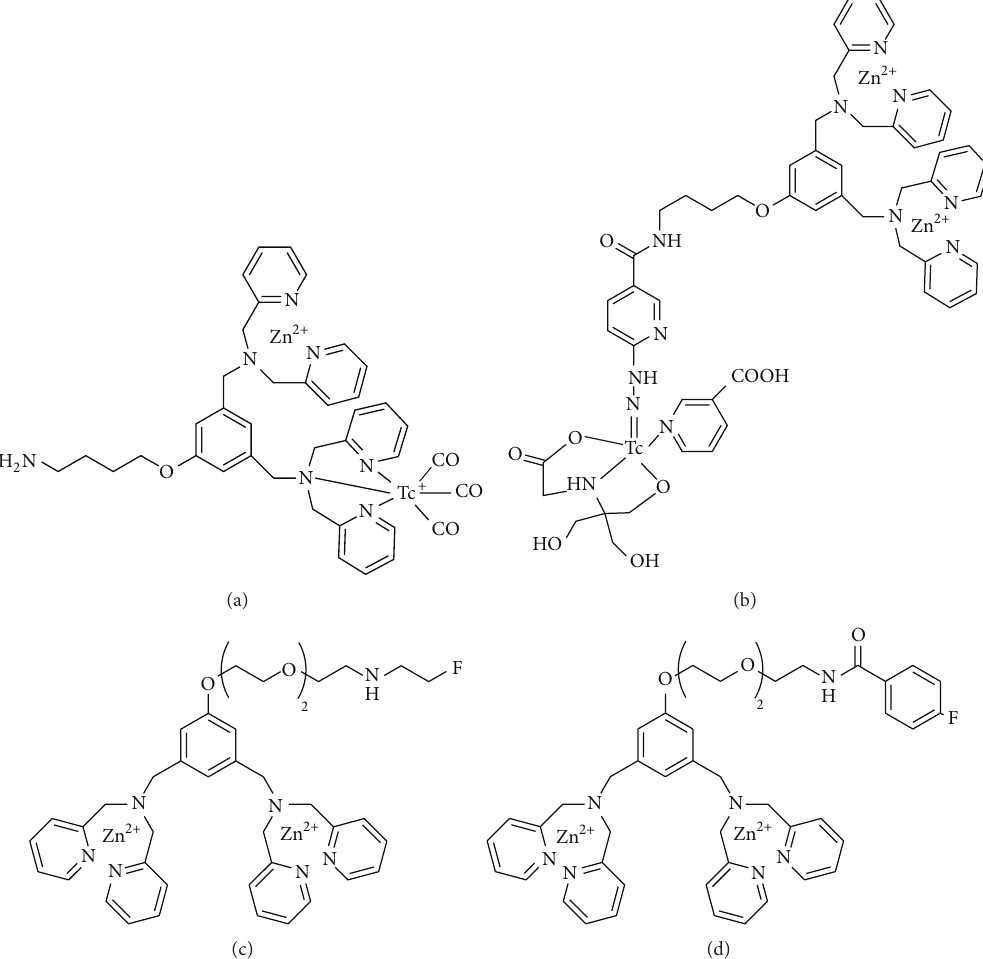
Figure 3: Structures of (a) 99 m Tc-labeled Zn 2+ -DPA with 99 m Tc-tricarbonyl core, (b) 99 m Tc-labeled Zn 2+ -DPA with 99 m Tc-HYNIC, (c) 18 F- FEN-DPAZn2, and (d) 18 F-FB-DPAZn2.